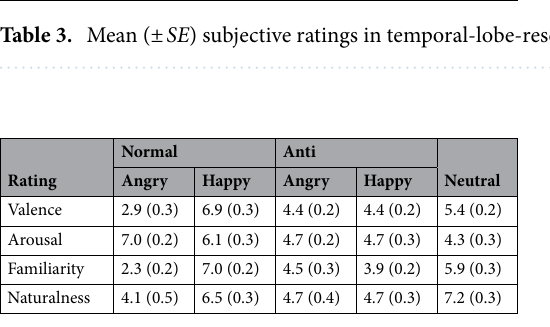
Table 4. Mean (± SE ) subjective ratings in